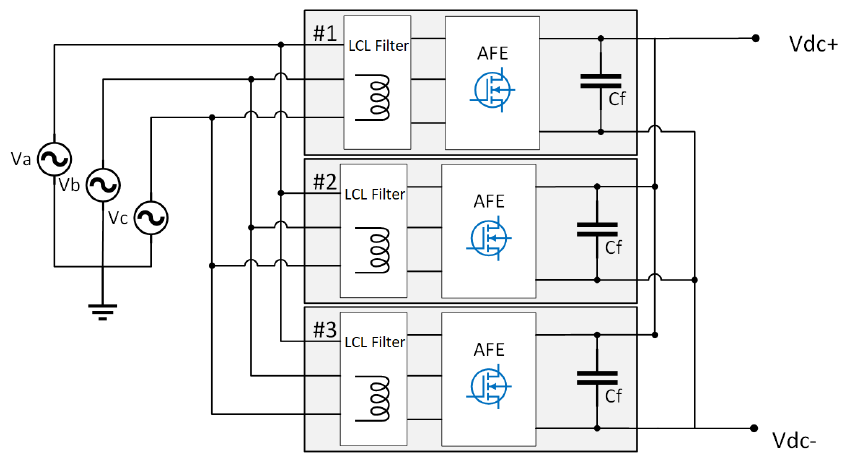
Figure 36. Modular AFE system consisting of parallel AFE